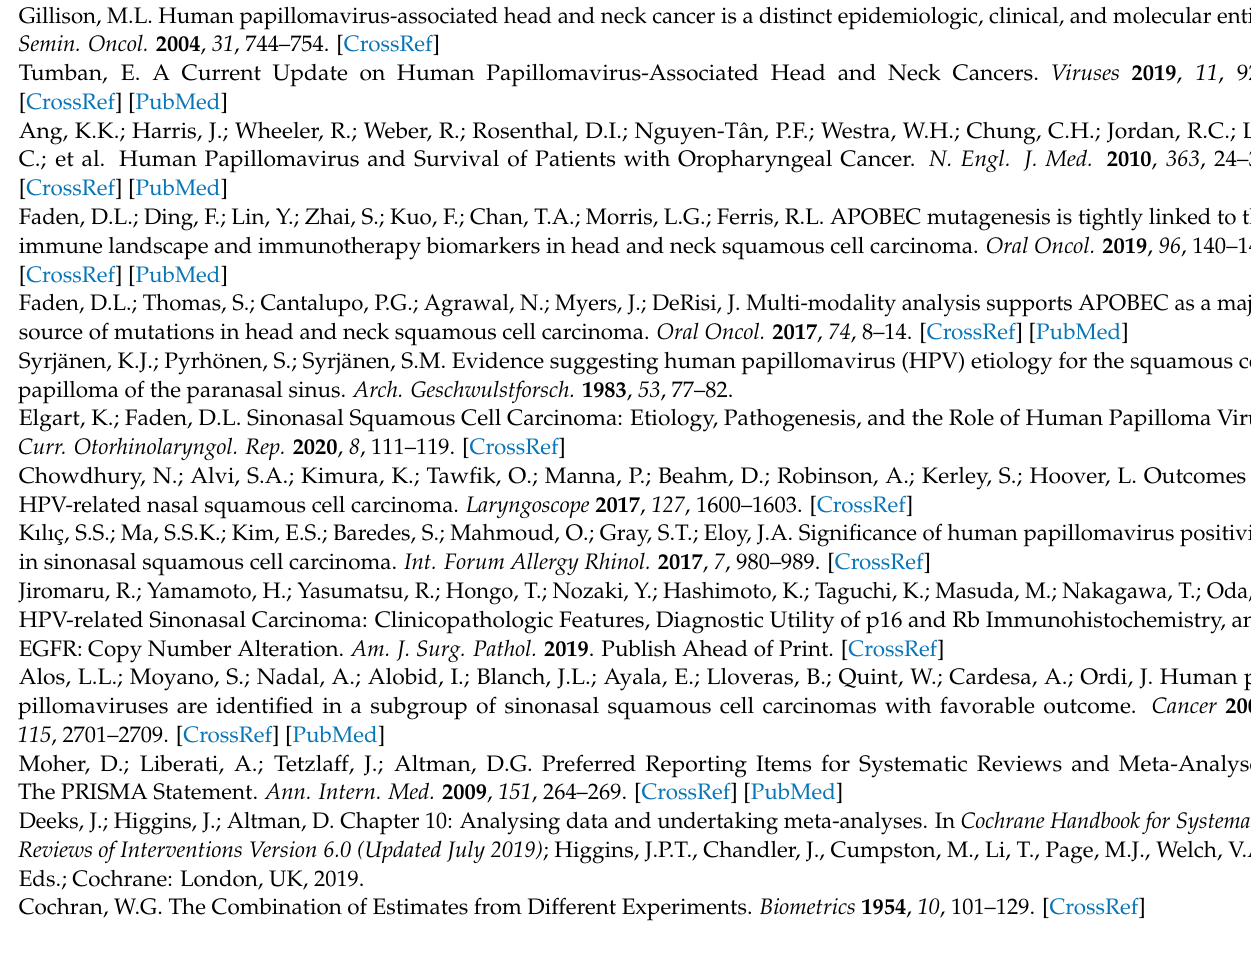
Table S1: Meta regression results, Table S2: Heterogeneity analyses for HPV prevalence subgroups using the fixed-effects model, Methods S1: Complete PubMed